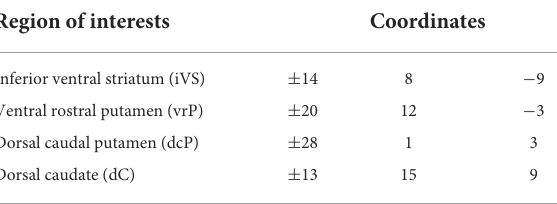
TABLE 2 Demographic data of the two